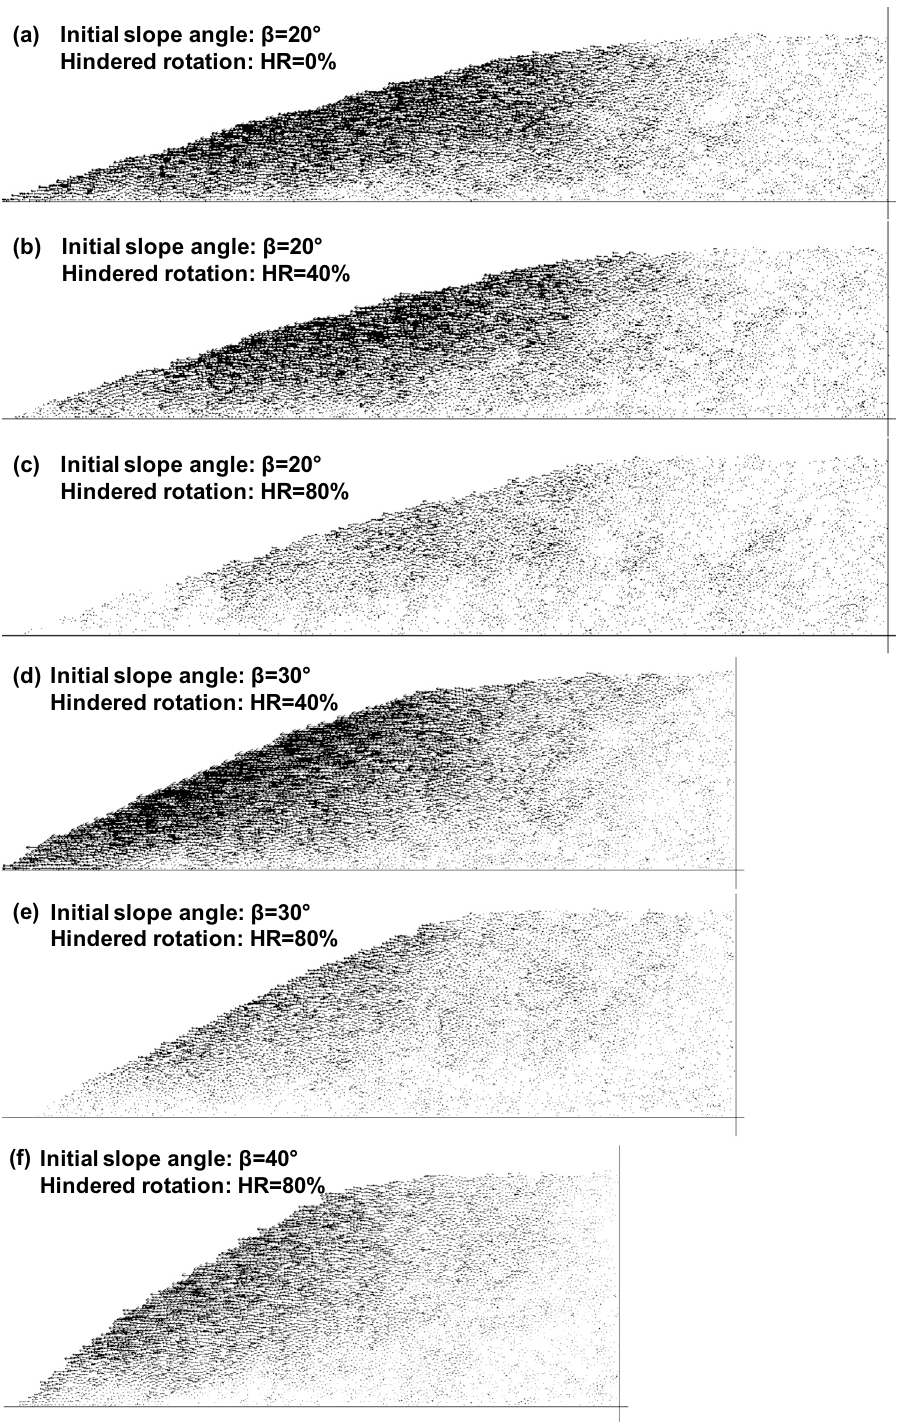
Figure 8. Horizontal component of the displacement vectors at the end of dissolution—All cases shown at the same displacement vector